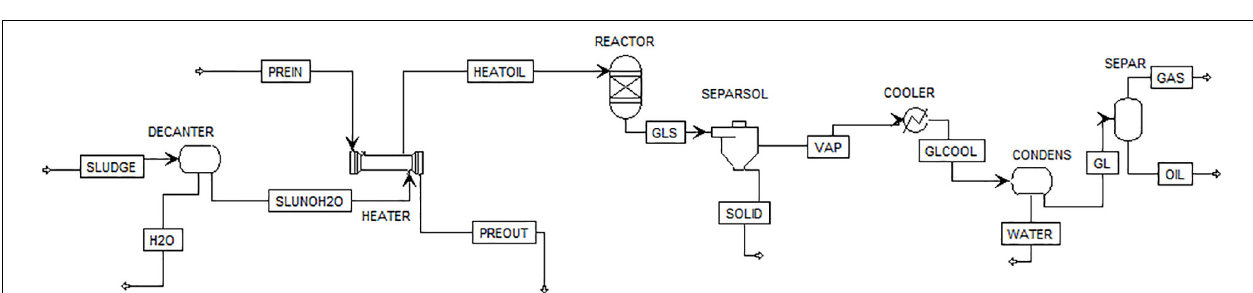
FIGURE 2 | Flow sheet of the Aspen Plus